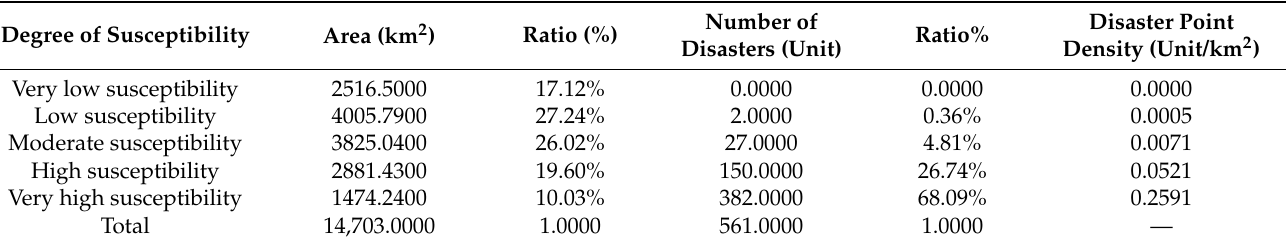
Table 4. Statistical table of CF model